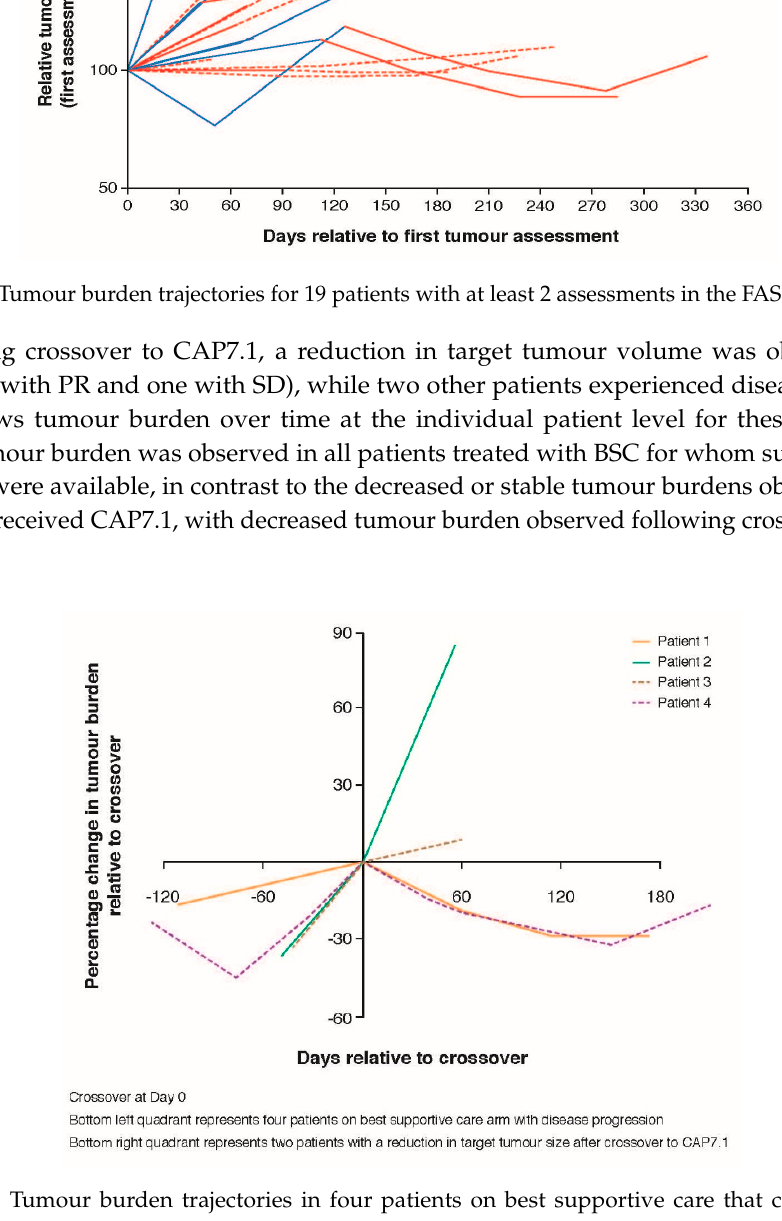
Figure 4. Tumour burden trajectories in four patients on best supportive care that crossed over to CAP7.1.